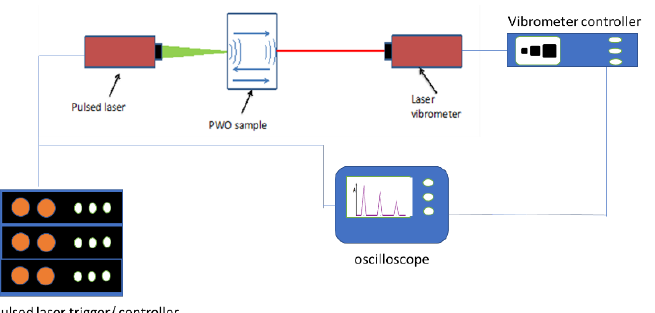
Figure 2. The experimental layout. The pulsed laser controller triggers both the laser and the acquiring oscilloscope.